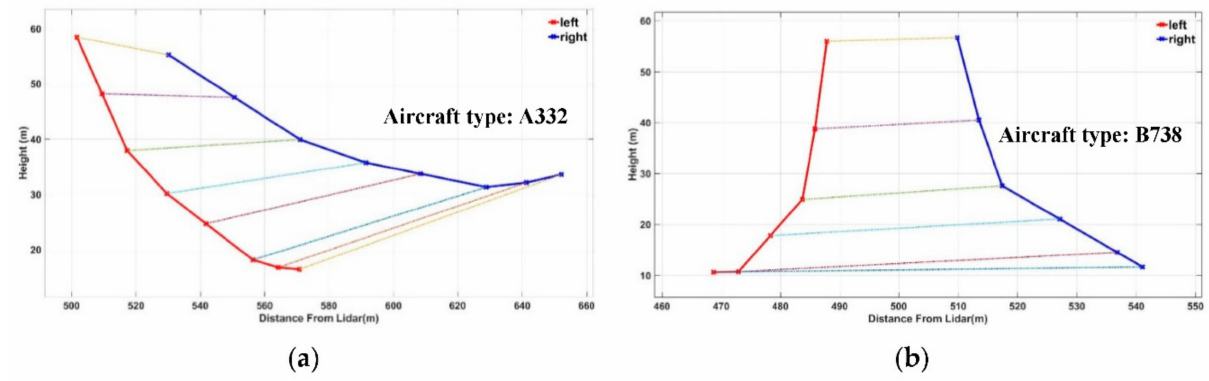
Figure 10. Wake vortex trajectories ( a ) with the stronger crosswind during 18:36:16~18:36:58 on 1 September 2018, and ( b ) without crosswind (or with gentle crosswind) during 11:22:41~11:23:51 on 27 August